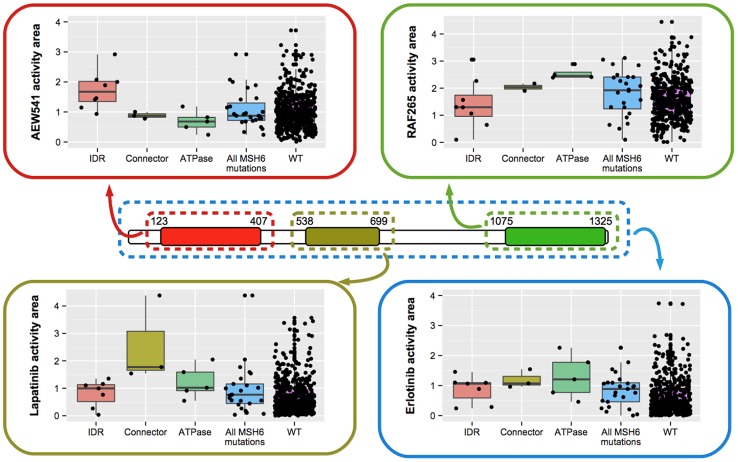
Perturbations of different regions in the same protein can have different drug effects.(a) Missense mutations in different PFRs of MSH6 lead to increased sensitivity towards three different drugs: AEW541, RAF5 and Lapatinib. The protein level analysis on the other hand reveals a potential association with Erlotinib (shown in blue). This highlights the complementarity between protein and PFR-centric approaches.